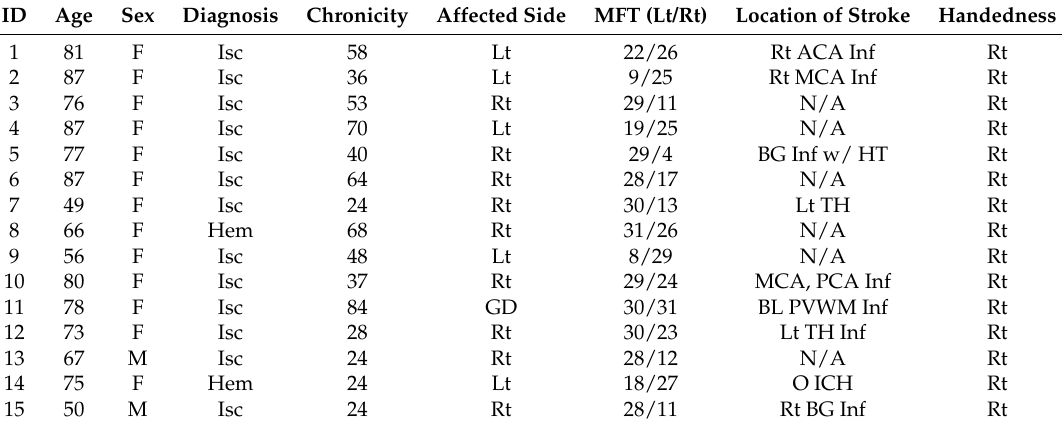
Table A4. Patient demographic information for the control